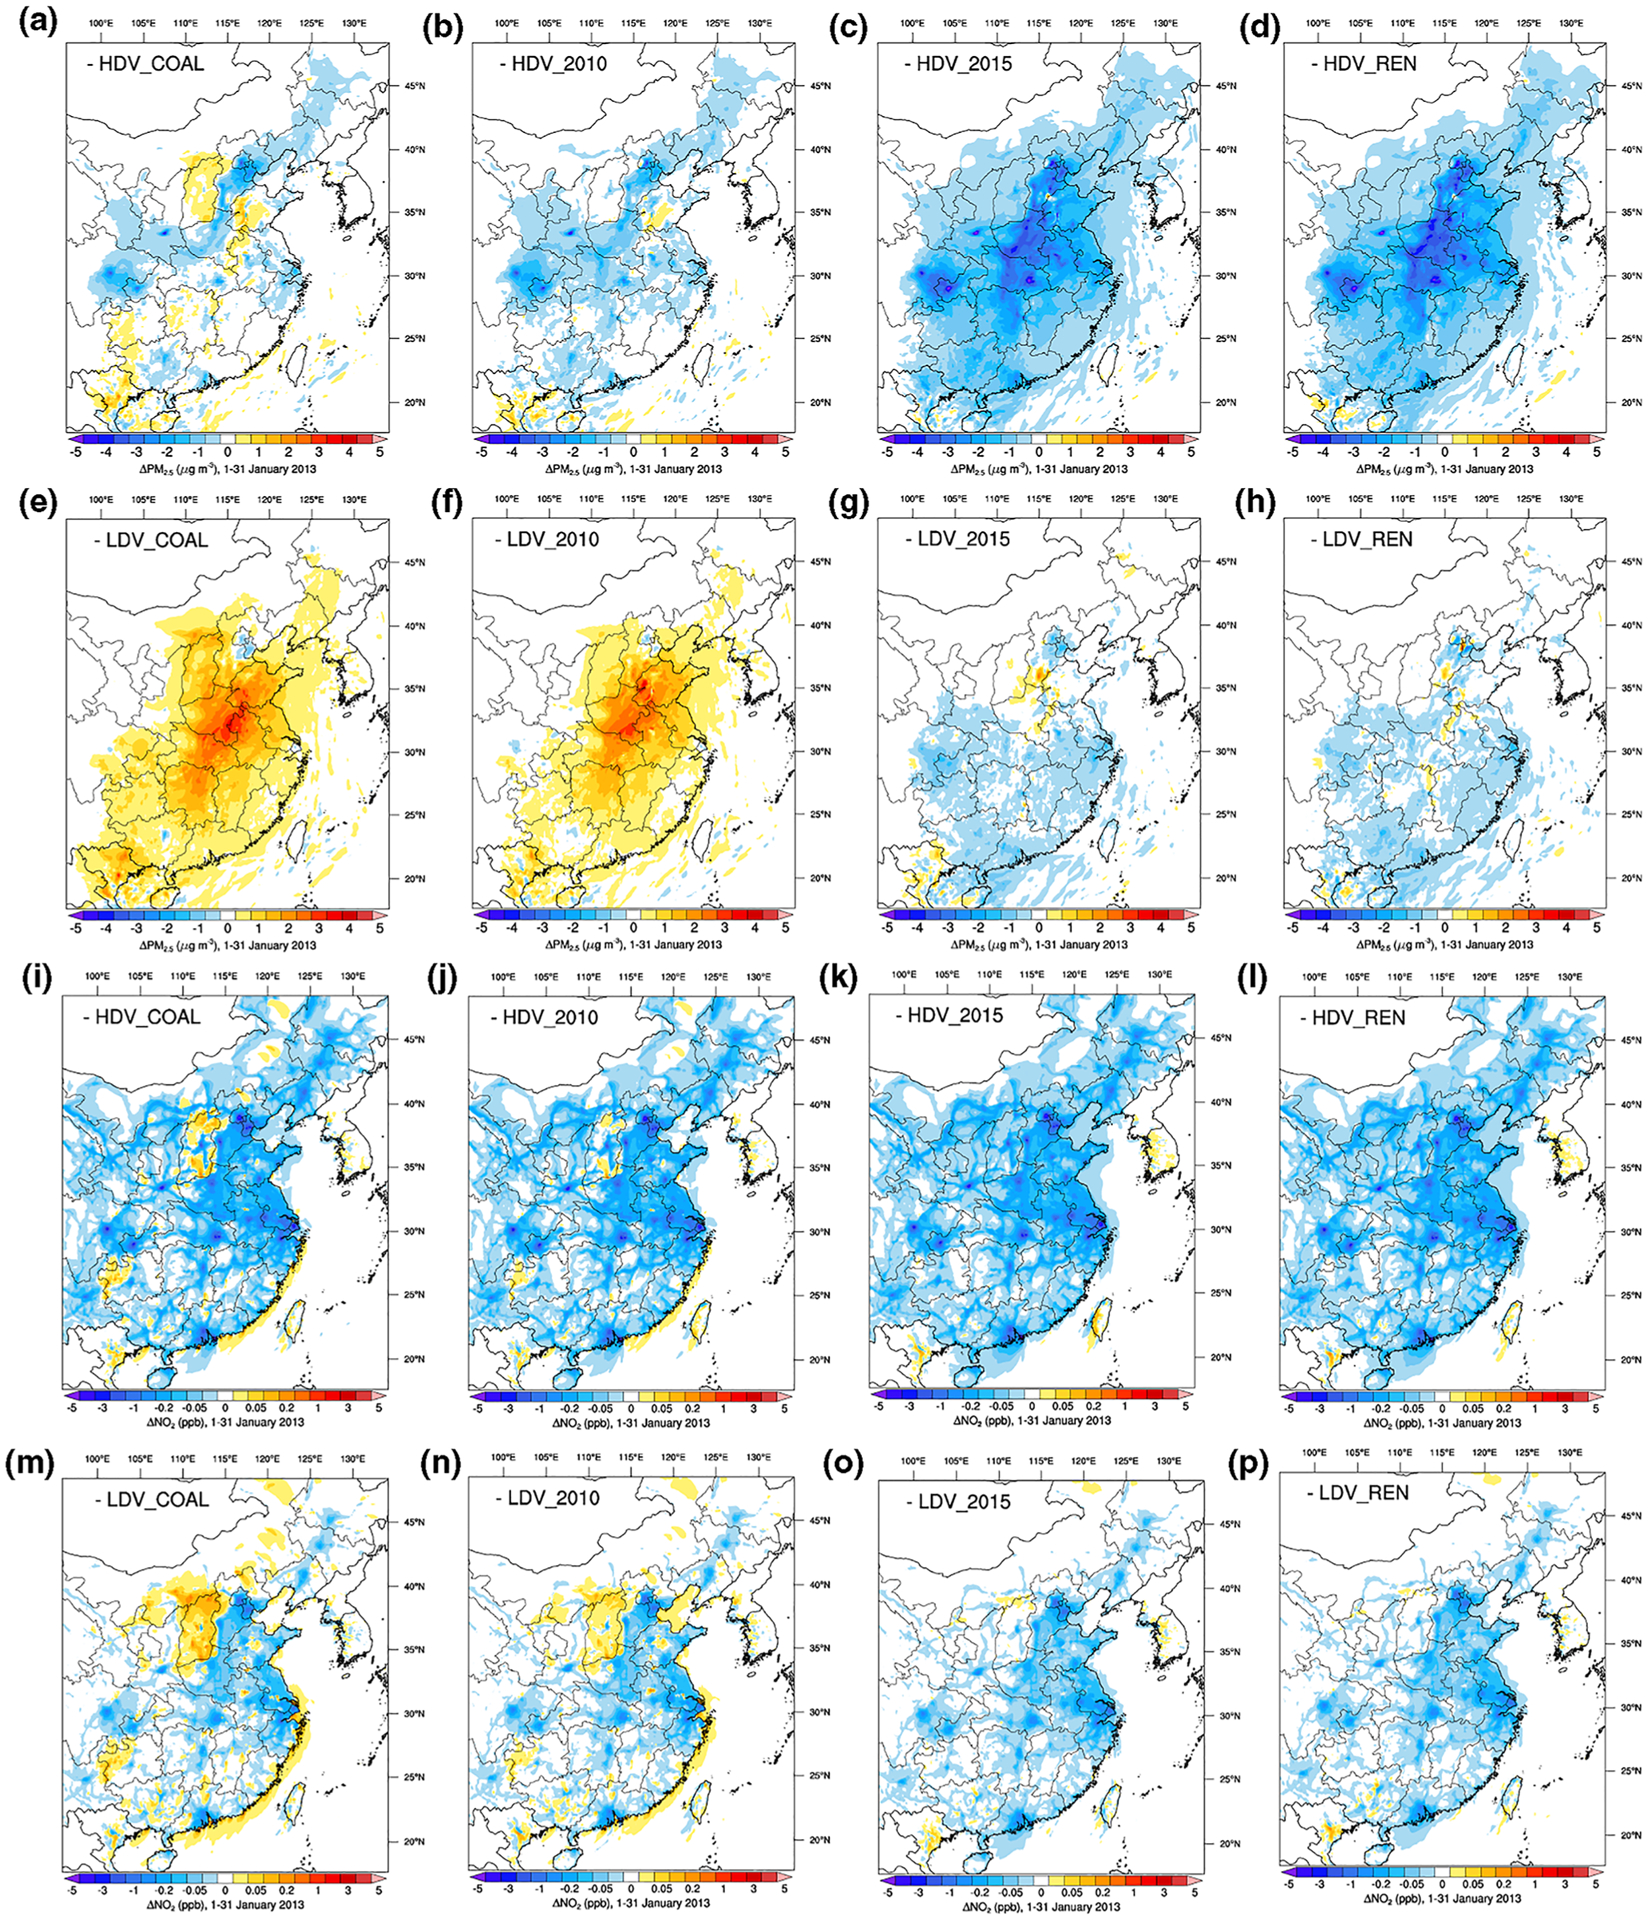
Mean changes PM2.5 (a–h, μg m3) and NO2 (i–p, ppb) changes for each experiment.